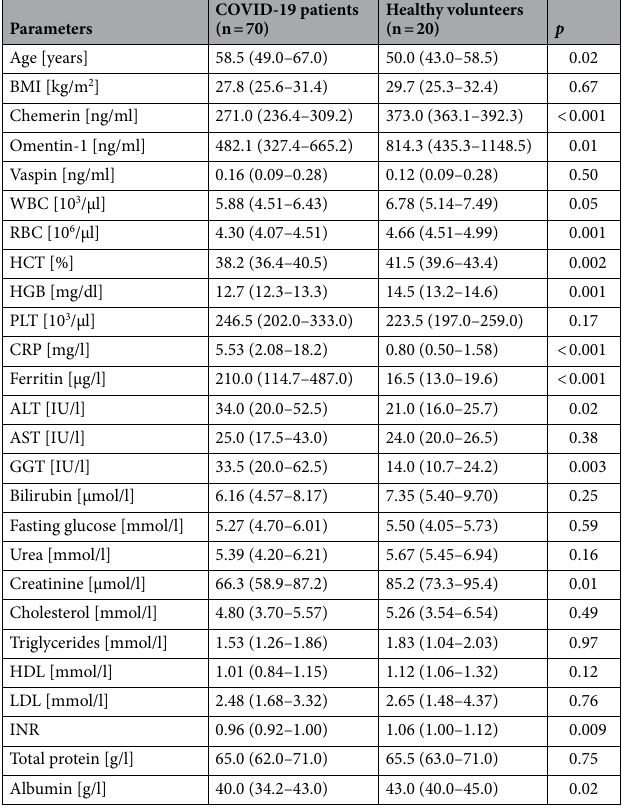
Table 1. The baseline characteristics and laboratory data of patients and healthy volunteers. ALT—alanine transaminase, AST—aspartate transaminase, BMI—body mass index, CRP—C-reactive protein, GGT— gamma-glutamyl-transferase, HCT—hematocrit, HDL— high-density lipoprotein, HGB—hemoglobin, INR— international normalized ratio, LDL—low-density lipoprotein, WBC—white blood cells, PLT—platelet count, RBC—white blood